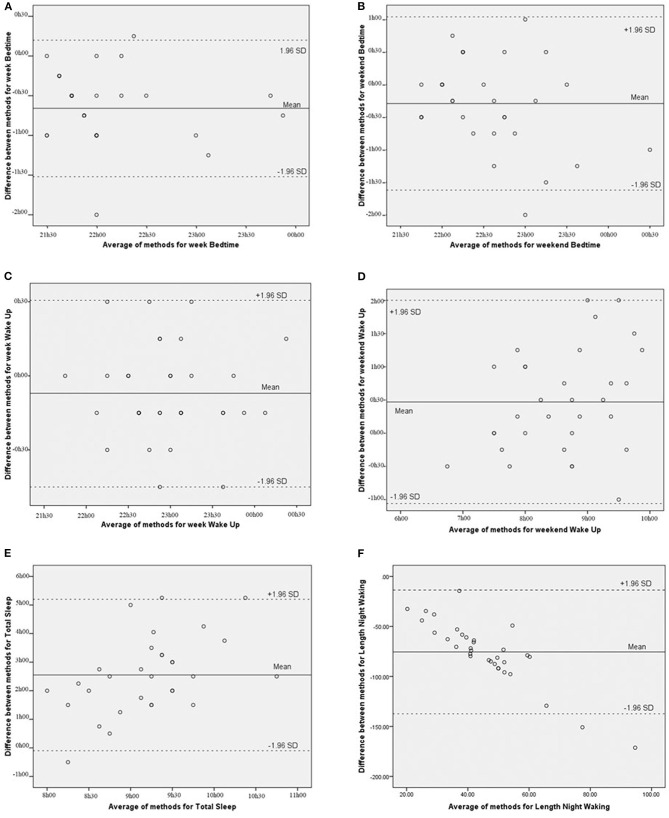
(A-F) Graphic representation of measurement differences between methods (CSHQ means - actigraph means) as a function of the mean differences between methods for specific parameters of bedtime (week and weekend), wake up time (week and weekend), total sleep time, and length of night waking.